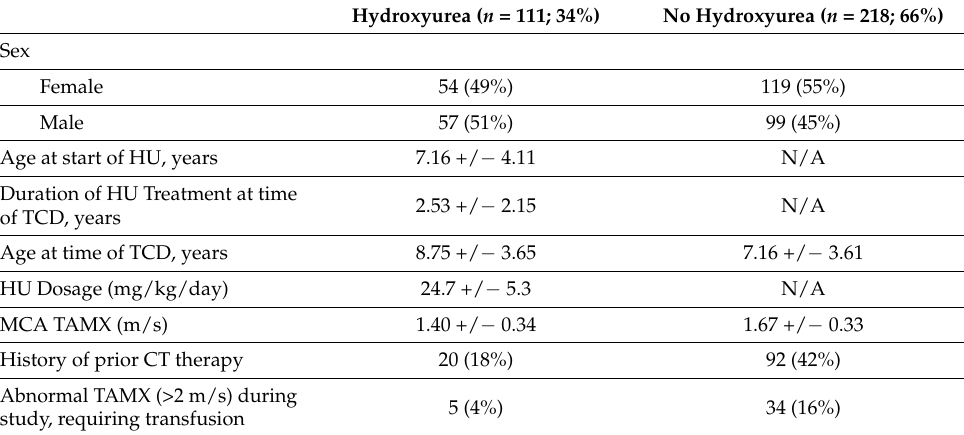
Table 1. Summary of patient information. As a retrospective chart review, age was determined to be relevant only in relation to time of treatment and TCD measurements. HU dosage was prescribed based on recommendations at the time and was titrated to a maximum tolerated dose as a function of body weight (kg). History of prior CT therapy was notably higher among those who were never treated with HU at the time of